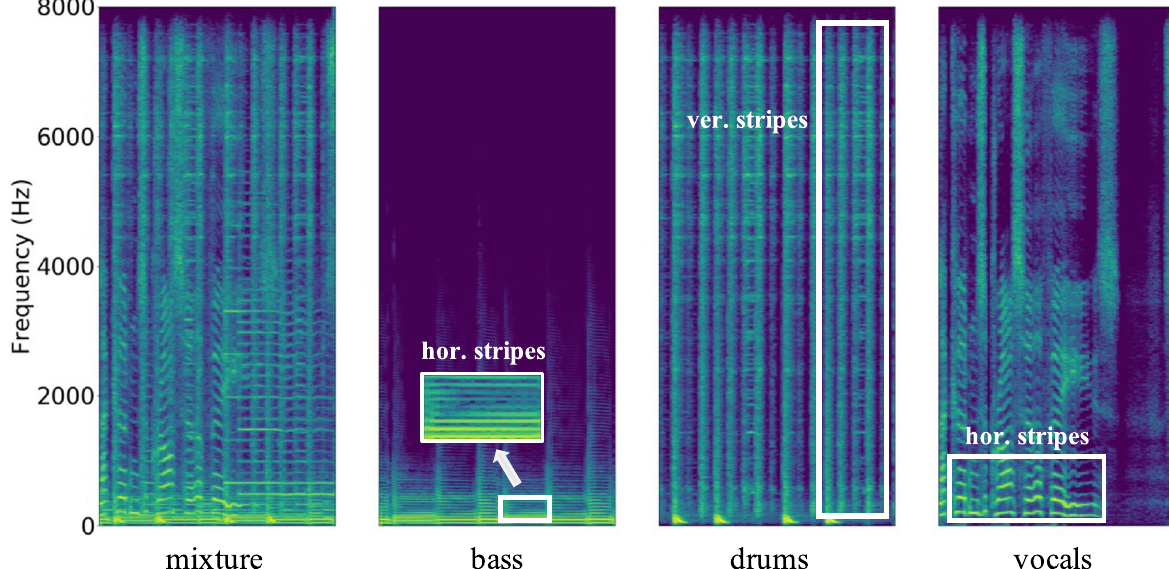
Fig. 1 Spectrograms of an example music piece and its source signals, in which horizontal and vertical stripes are